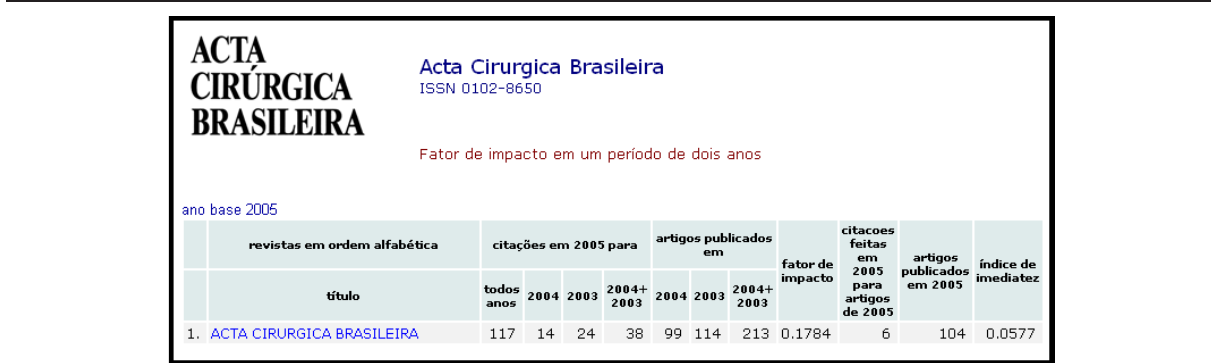
FIGURA 6 - Fator de impacto em um período de dois